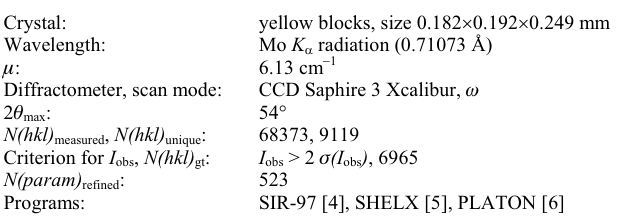
Table 2. Atomic coordinates and displacement parameters (in Å 2 )